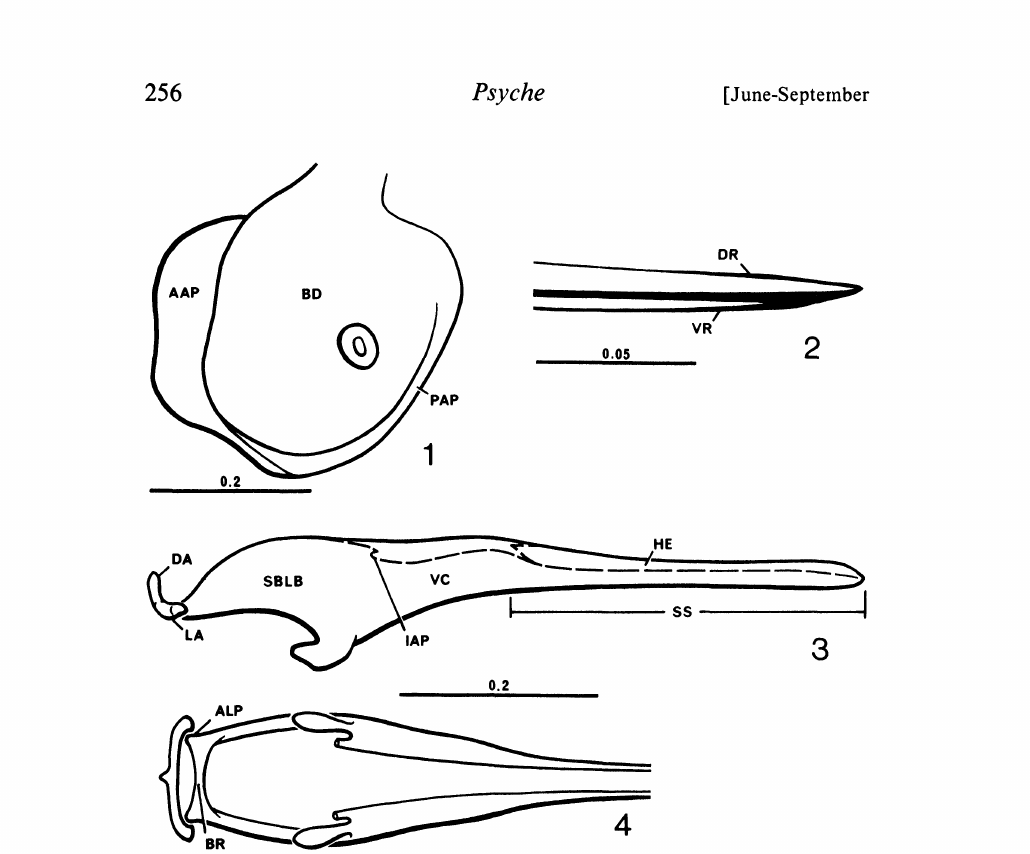
Figures 1-4. Sclerites of the sting apparatus of Eutetramorium mocquerysi. Fig. 1, spiracular plate, side view. Fig. 2, apical 1/4 of lancet, side view. Fig. 3, sting and furcula, side view. Fig. 4, sting and furcula, ventral view. Abbreviations: AAP, anterior apodetne; ALP, anterolateral process of sting base; BD, body; BR, basal ridge; DA, dorsal artn of furcula; DR, dorsal ridge; HE, hetnocoel; lAP,